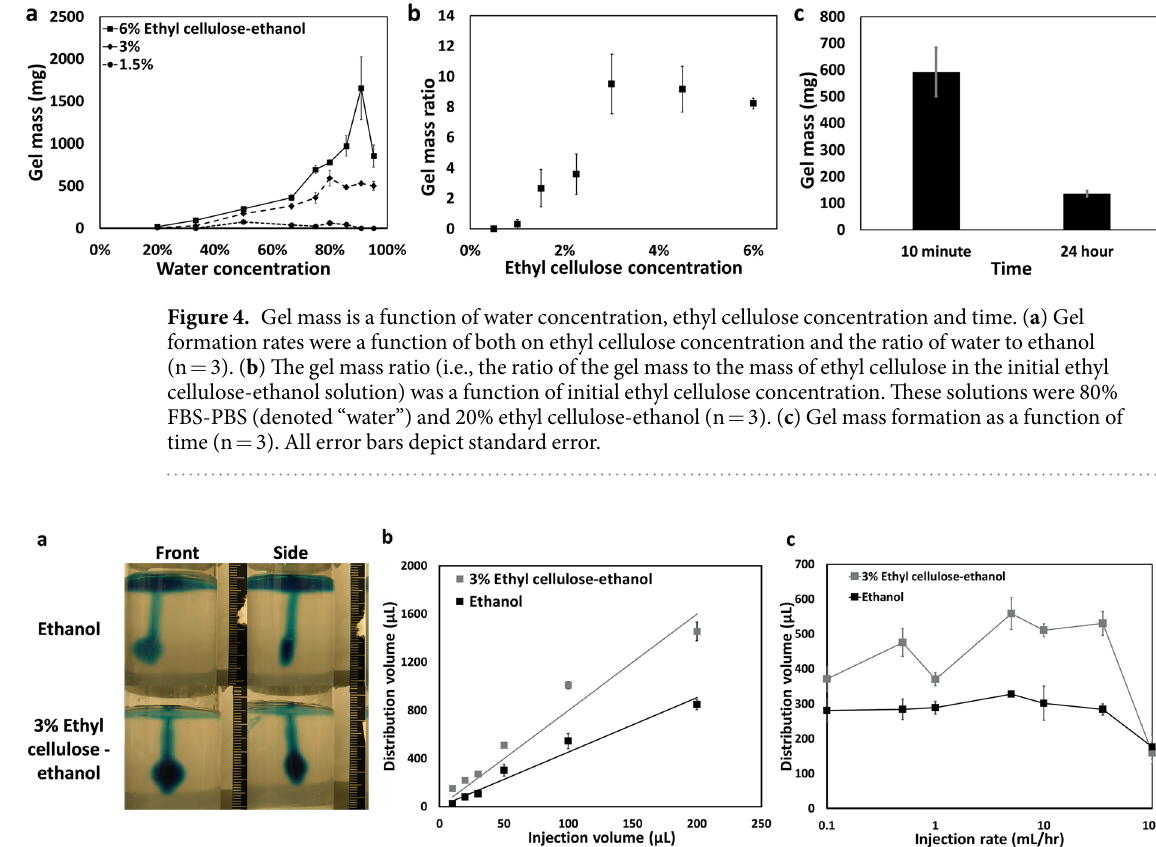
Figure 5. Distribution volume varies with injection rate, injection volume, and ethyl cellulose concentration. ( a ) Representative images of 50 μ L of ethanol or 3% ethyl cellulose-ethanol injected into agarose tissue phantoms at 10 mL/hr. Images were taken from the perspective with the widest cross-sectional area (“Front”) and the orthogonal perspective (“Side”). Distribution volume was calculated from front and side images of each phantom, assuming that the distribution shape was an ellipsoid. ( b ) Distribution volume as a function of injection volume for 10 mL/hr injections of either ethanol or 3% ethyl cellulose-ethanol. The linear fits had slopes of 8.1 and 4.7, respectively. Each injection volume was performed 5 to 7 times. ( c ) Distribution volume as a function of injection rate for both pure ethanol and 3% ethyl cellulose-ethanol. Mean distribution volume of ethyl cellulose solution was higher than for ethanol alone (p < 0.01, exact p-value < 10 − 7 , chi-square = 29.04, degrees of freedom = 1). Each injection rate was evaluated 7 times. All error bars depict standard error of the